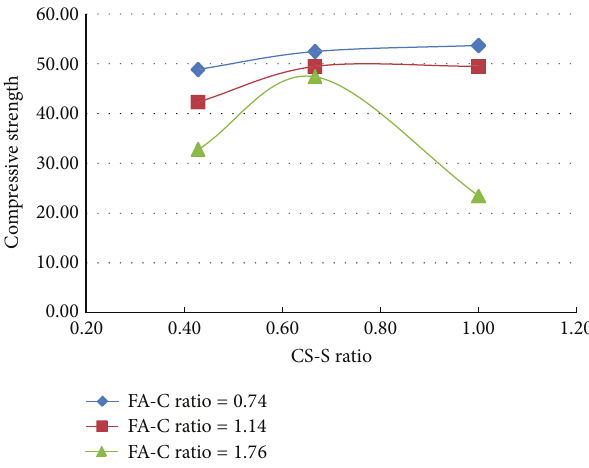
Figure2:CompressivestrengthversusCS-Sratio(specimensS1–S9: without